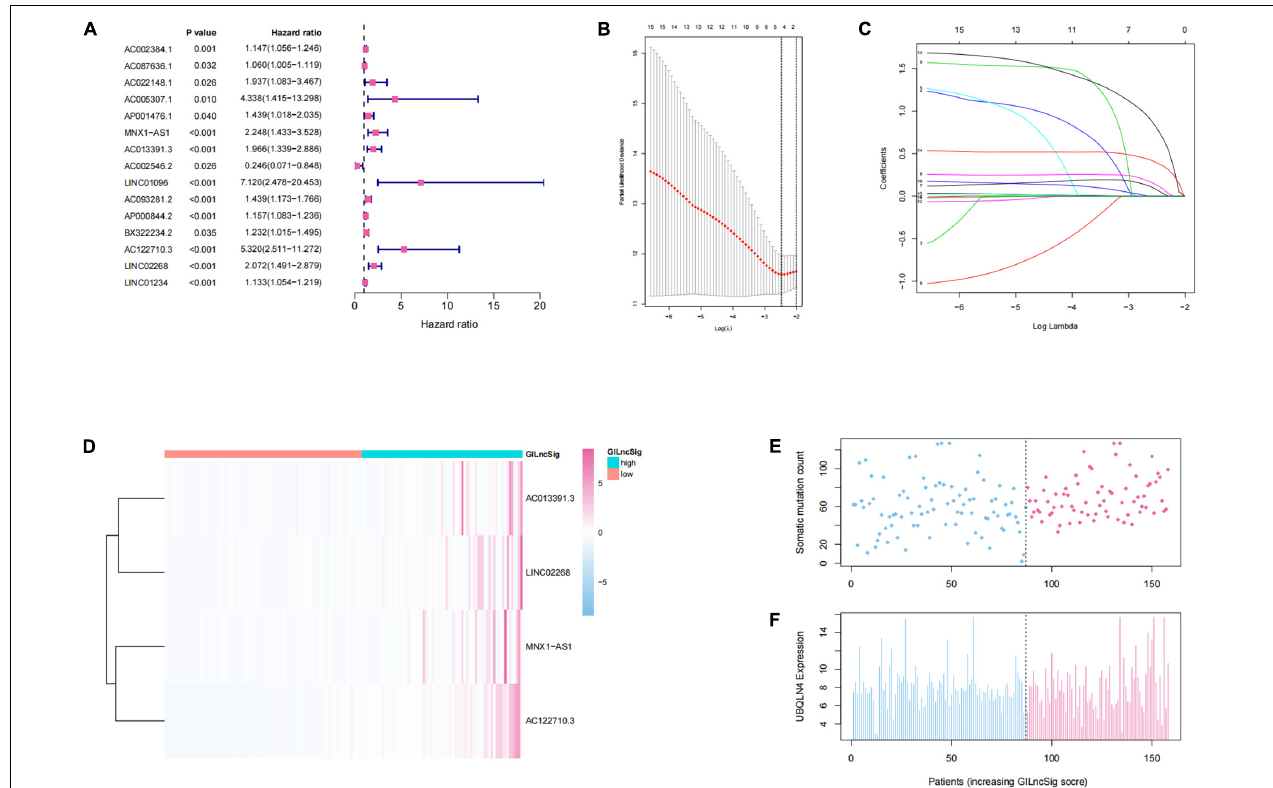
FIGURE 2 | Establishment and identification of the genomic instability-derived lncRNA signature (GILncSig) for outcome prediction in the training set. (A) Forest plot of 15 lncRNAs, which has a significant association with the prognosis of ccRCC. (B,C) Lasso regression model for 15 prognostic lncRNAs used to construct GILncSig. (D) Heatmap of lncRNAs in GILncSig between the high-GILncSig and low-GILncSig groups (divided by median value) in the training set. (E) Distribution of somatic mutation counts in ccRCC patients. (F) Distribution of the expression level of UBQLN4 in ccRCC patients.